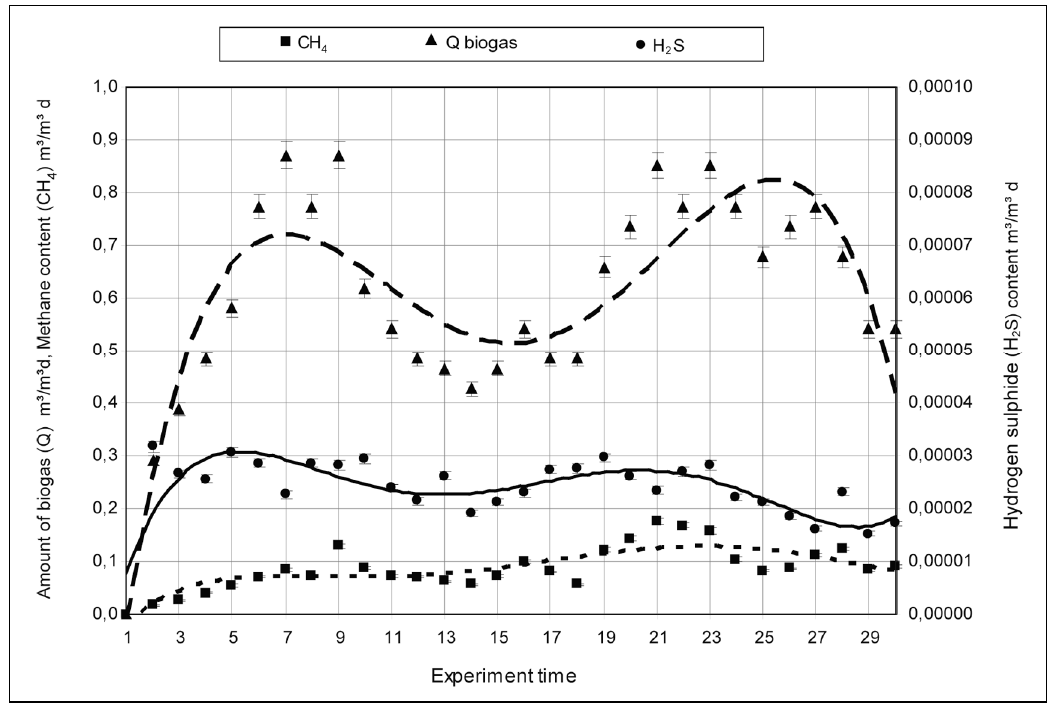
3 3 3 3 /m d), methane (m /m d) and hydrogen sulphide (m